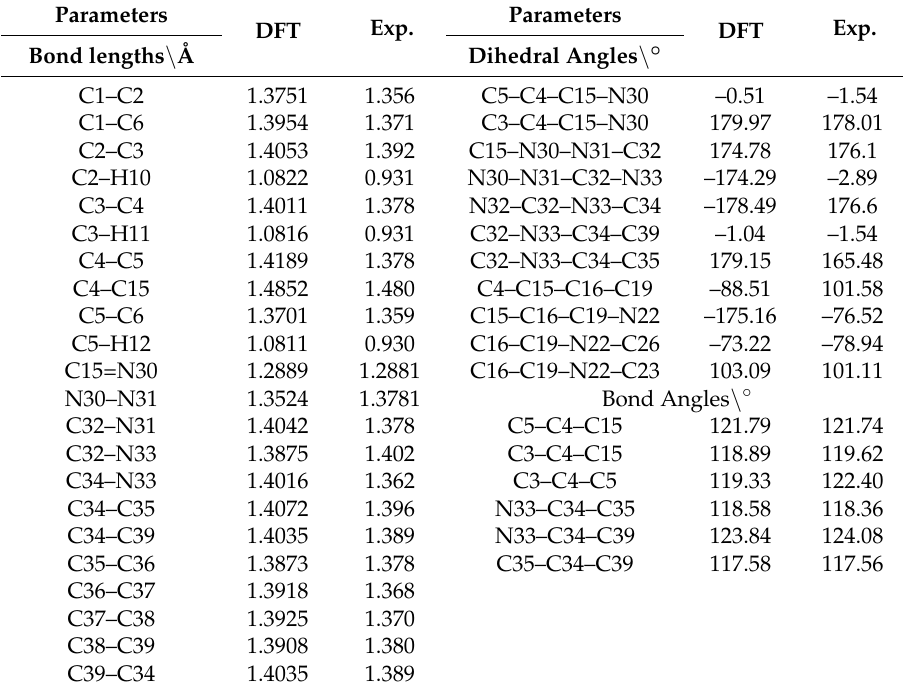
Table 4. Selected optimized parameters for the semicarbazone 4